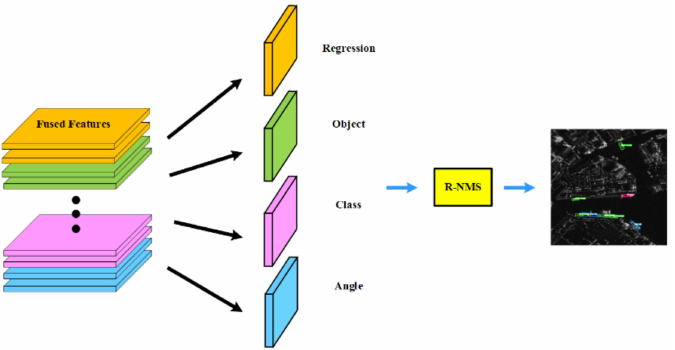
Figure 4. The structure of the oriented bounding box (OBB) prediction